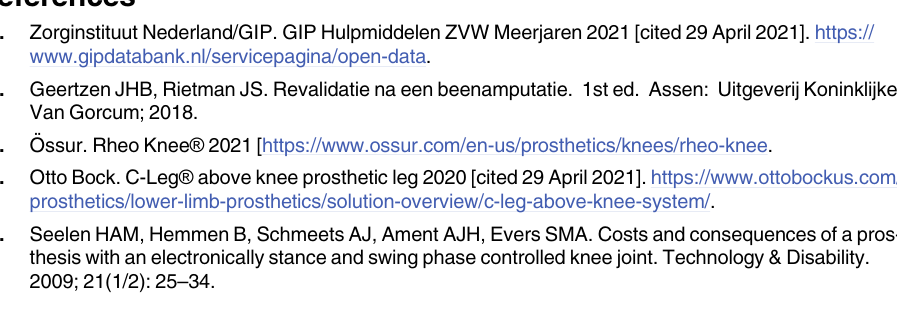
S1 Table. Consolidated criteria for reporting qualitative research (COREQ). S2 Table. Preliminary, pre-final and final framework. S3 Table. PRISMA 2020